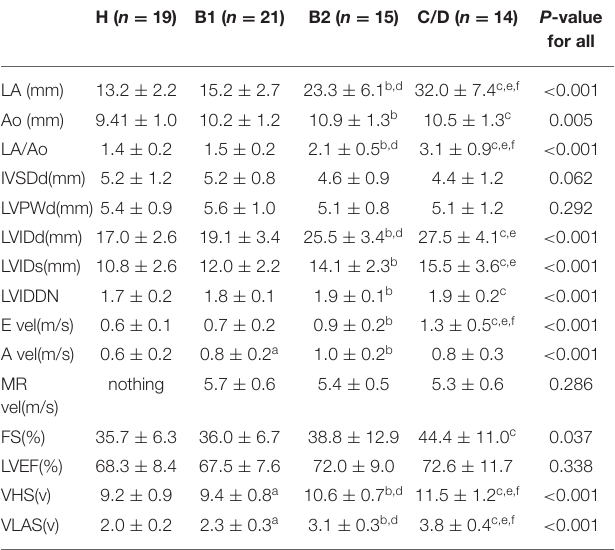
TABLE 2 | Echocardiographic and radiographic data in healthy Chihuahuas (H) and Chihuahuas with myxomatous mitral valve disease divided into three groups (B1, B2, and C/D).